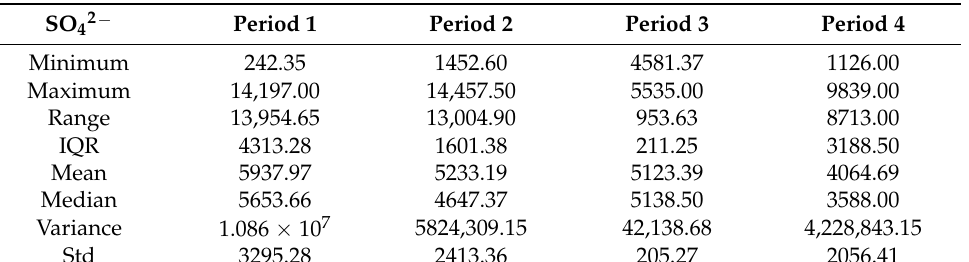
Table 3. Summary statistics for SO 42 − in different periods.